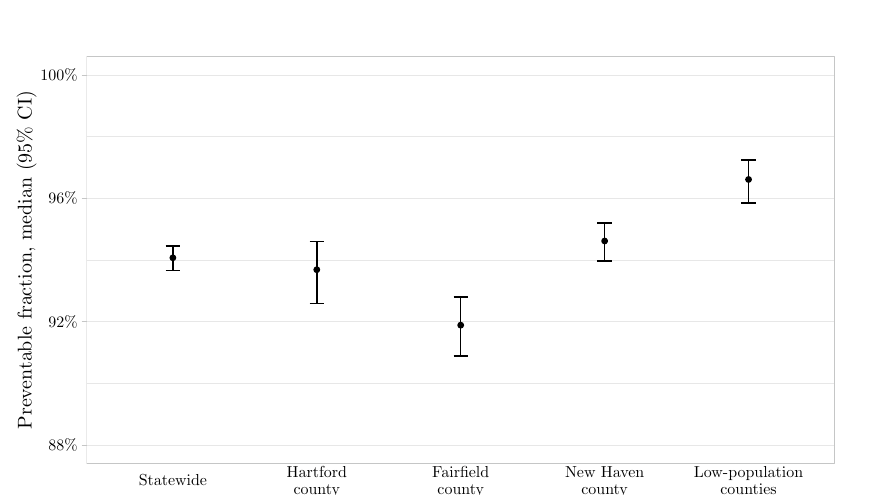
Figure 2. County-level variation in RSV season onset and offset in Connecticut Figure created using ggplot2 version 3.3.2 (https:// ggplo t2. tidyv erse. org).